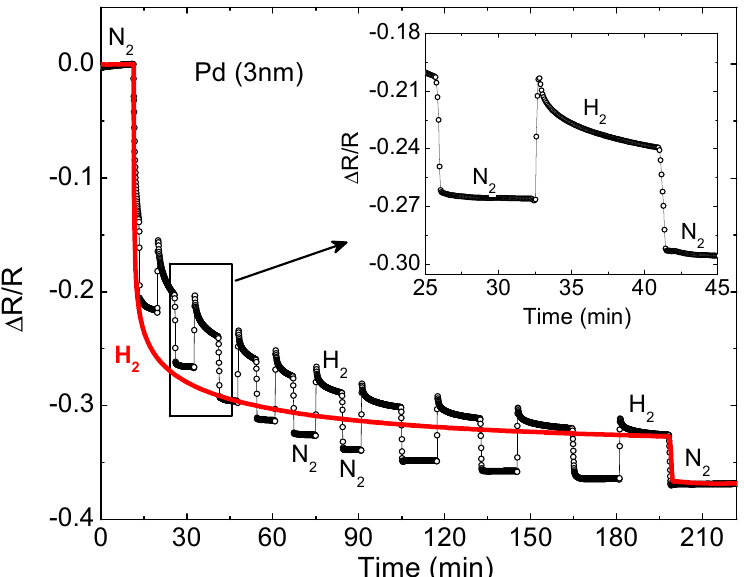
Figure 2. Time-dependent normalized resistance of 3 nm thick Pd exposed continuously to a 4% H 2 /N 2 mixture (solid red line) and to a sequence of hydrogenation and dehydrogenation cycles (open circles). Inset: zoom on one of the H 2 -N 2 cycles. Resistance is frozen in N 2 and decreases in H 2 . The time dependence of the normalized resistance changes due to hydride formation ∆(cid:3019) (cid:3257) thickness expansion ∆(cid:3019) (cid:3269) ∆(cid:3019) (cid:3269),(cid:3288)(cid:3276)(cid:3299) are shown in Figure 3a,b, respectively, for a number of 15 nm thick CoPd films with different Co concentrations, including a pure Pd film. ∆𝑅 (cid:3009)((cid:3021)),(cid:3040)(cid:3028)(cid:3051) are the largest saturated values of the respective changes for each sample. Figure 3c presents the effective time of each process 𝑡 (cid:3009),(cid:2873)(cid:2868) and 𝑡 (cid:3021),(cid:2873)(cid:2868) defined as the time at which the respective resistance term changed by half. Hydride formation is accomplished within a few tens to hundred seconds in all samples. In alloys, the process of hydride formation is quicker with increasing Co content: t 50 = 60 s in Co 10 Pd 90 down to a few s in Co 40 Pd 60 . The increase in the diffusion rate in diluted Pd alloys is consistent with that reported for NiPd alloys [31]. The thickness expansion time scale is entirely different: from 10 s in the x = 20 sample to 10 5 s in the x = 80 one. 𝑡 (cid:3021),(cid:2873)(cid:2868) can be approximated by: 𝑡 (cid:3021),(cid:2873)(cid:2868) ∝ 𝑒 (cid:3051) (solid line in Figure 3c), i.e., it increases exponentially with the concentration of Co.